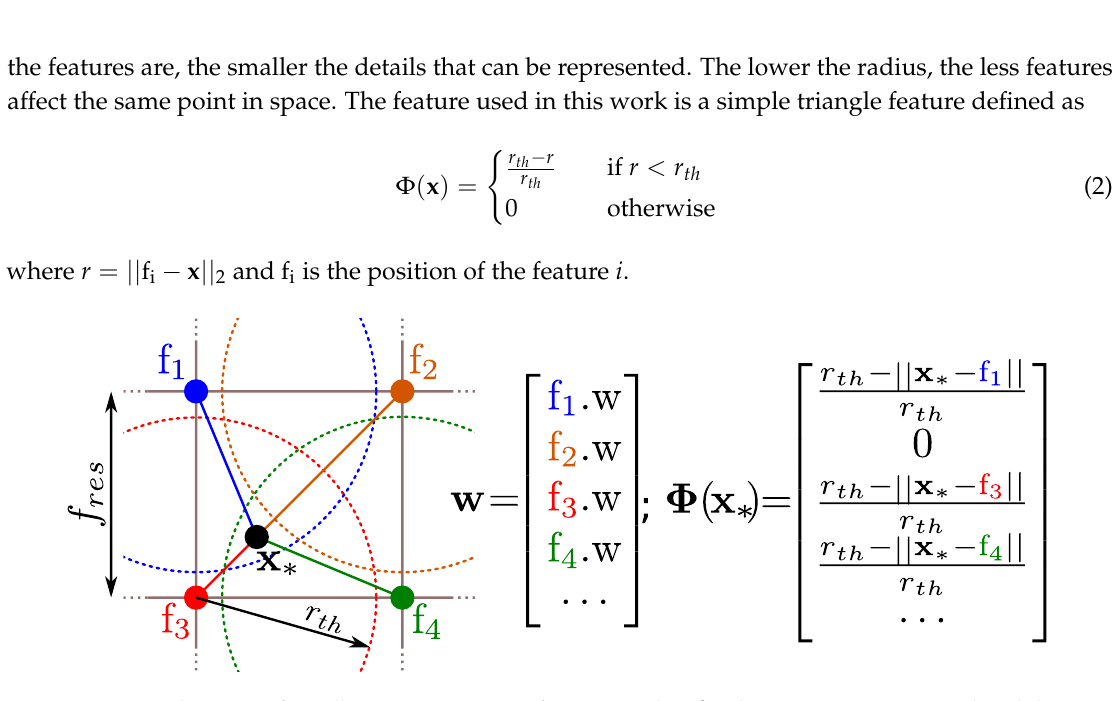
Figure 1. Schematic of a Hilbert Map. Features f i are spread at f res distance in a square grid and the neighbourhood that they affect is defined by the radius r th . When predicting the occupancy of a point x ∗ , one must gather all the feature weights and multiply it by the value of the feature in that point Φ ( x ∗ ) according to (1). In the example shown, the query point is outside f 2 neighbourhood and thus, its contribution is zero.